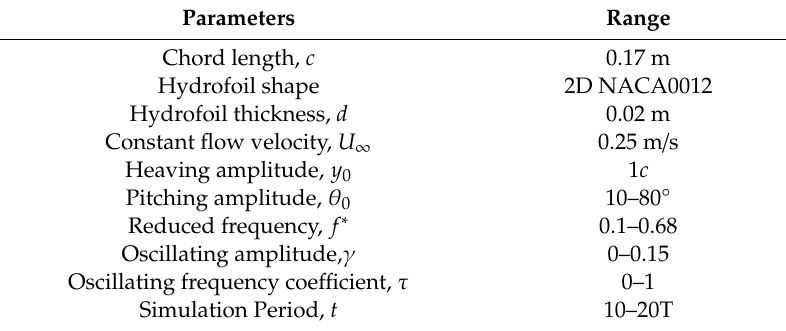
Table 2. Main characteristics for